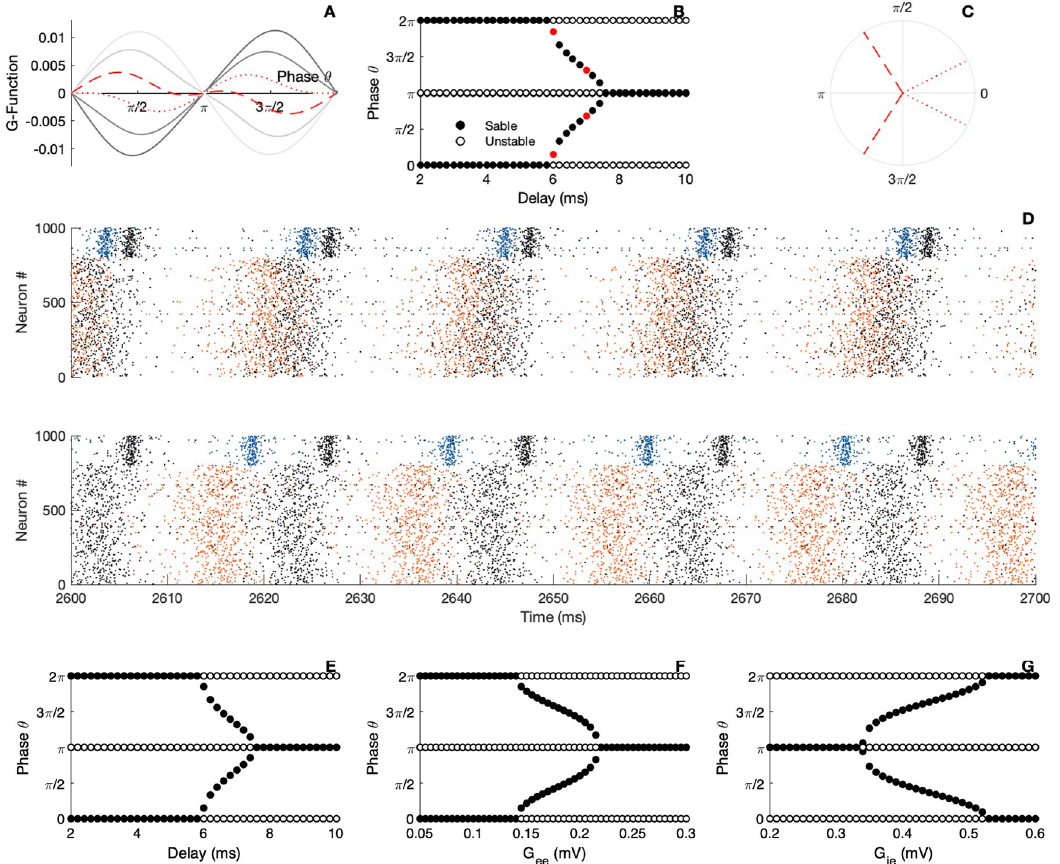
Fig 6. Bifurcation analysis of locking modes with respect to delay for the PING. A) The panel gives the G -function for different parameter d . B) Bifurcation analysis. The circles are filled for stable fixed point and empty for the unstable points, red dots represent the illustrations parameters C) Resulting locking modes. D) Raster plot of the spiking activity of the two neural networks, black dots indicate the spike timing of the first network, colored dots indicate the spike timing of the second network. E-F-G) Bifurcation analysis. The circles are filled for stable fixed point and empty for the unstable points. panel E) bifurcation parameter d , panel F) bifurcation parameter G , panel G) bifurcation parameter G . Parameters: N = N = 5000; τ = τ = 10; τ = τ = 1; � Z ¼ � Z ¼ (cid:0) 5 ; J ee ie e i e i se si ee e i = 0; J ei = 15; J ii = 0; J ie = 15; I ext ¼ 0 ; v th = 500; v r = − 500; I e ¼ 10 ; G ee = 0.1; G ie = 0.5; B) upper panel d = 6, lower panel d = 7; E) G ee i ext = 0.1; G = 0.5; F) G = 0.5; d = 6; G) G = 0.1; G = 0.1; d = ie ie ee ee